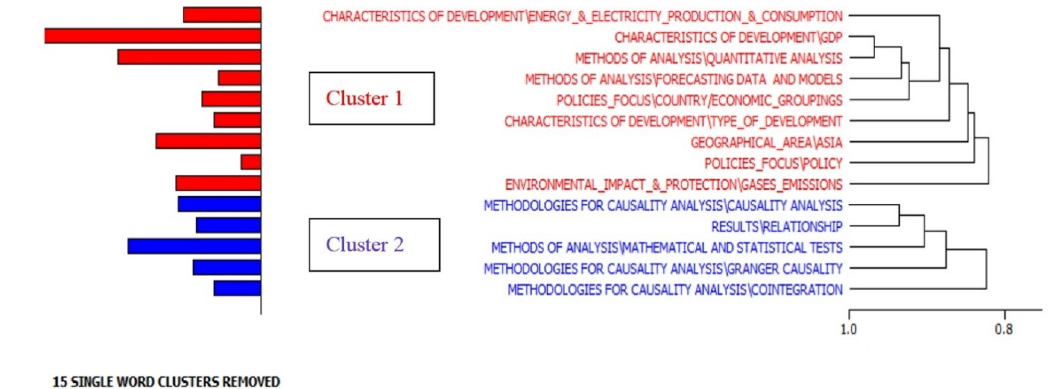
Figure 2. Dendrogram of the similarities between descriptors for the entire period (1979–2019).